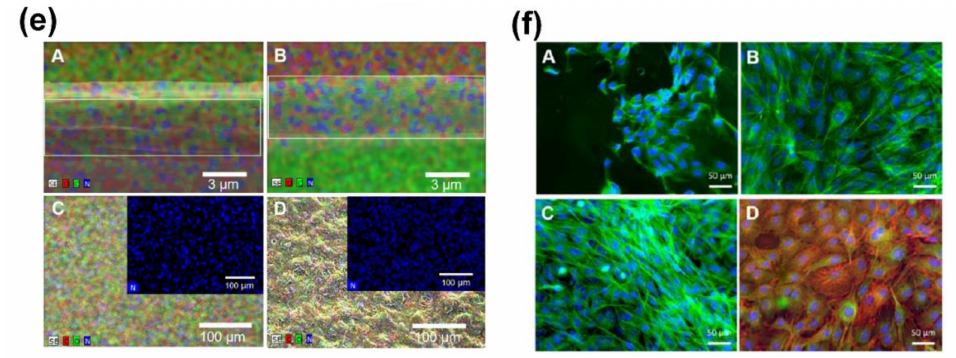
Figure 3. ( a ) Confocal microscopy images of differentiated neurospheres on day 7; ( b ) average percentages of differentiated cell phenotypes after 7 days in culture; ( c ) schematic showing LbL assembly of polyelectrolytes based on electrostatic interactions for tuning cell adhesive properties using cross-linking; ( d ) schematic illustration of the fabrication and cell uptake of LbL assembly multilayers embedded with β -estradiol-silica nanoparticles onto substrates; ( e ) mixed element map of the cross-section and upper surface of different catechol-based freestanding membranes; ( f ) Osteopontin immunofluorescence images of cells after 14 days cultured on different catechol-based freestanding membranes. Reprinted from [24,72,77] with permissions from American Chemical Society, Elsevier, and